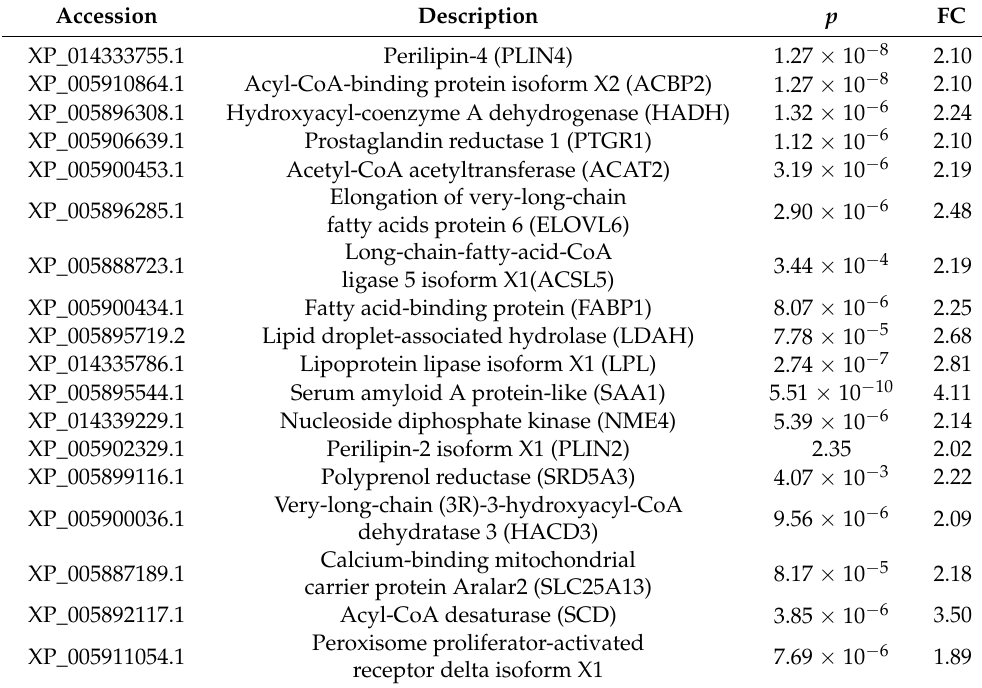
Table 3. Crucial differentially expressed proteins (DEPs) involved in unsaturated fatty acid (UFAs) metabolism in yak subcutaneous